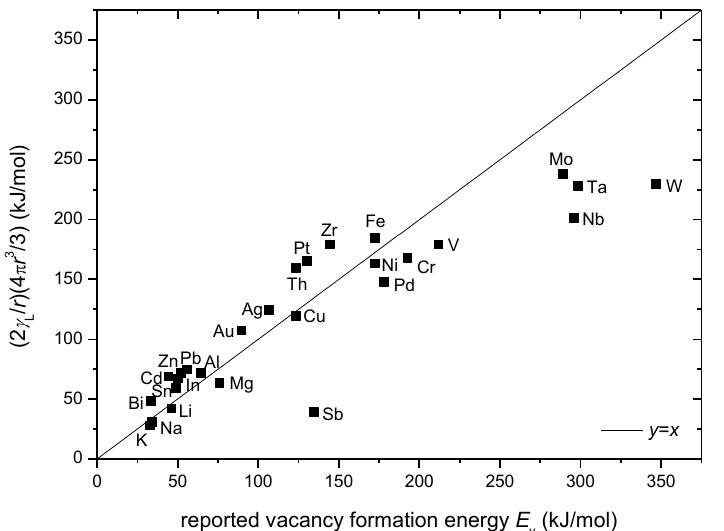
Figure 6. Measured vacancy formation energy E v [27] in comparison with the calculated E v according to Equation (8) by using the reported surface tension  L for liquid metals [33] and atomic radii r data